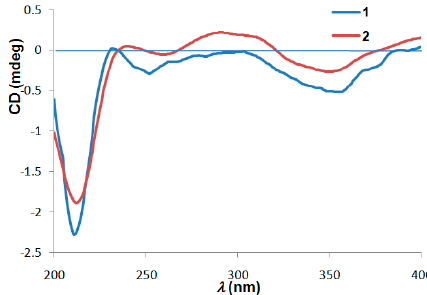
Figure 4. Experimental electronic circular dichroism (ECD) spectra of 1 and 2 (in CH 3 OH).